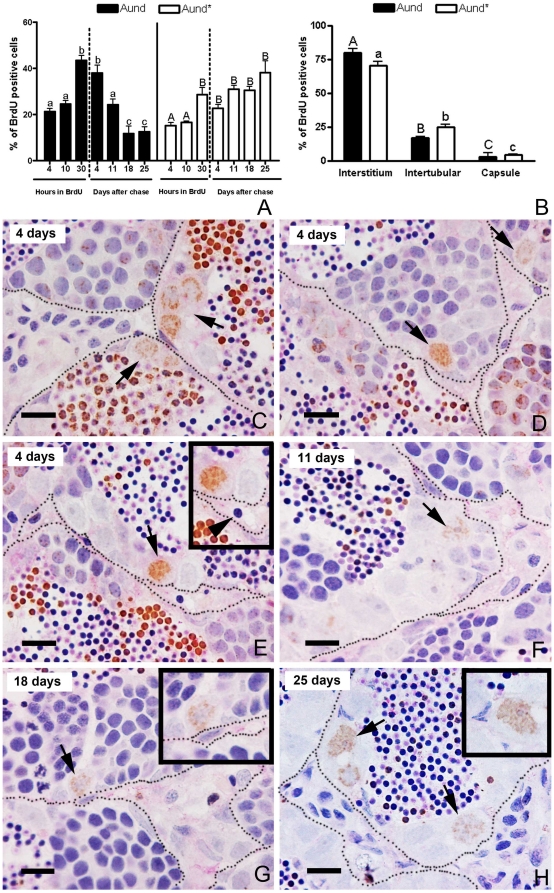
Label retaining cell (LRC) approach in zebrafish testes.
A. BrdU labeling index of type Aund* and Aund during BrdU exposure (4, 10, and 30 h) and after 4, 11, 18 and 25 days of chase. Bars represent the percentage mean ± SE (n = 5); different letters denote significant differences (p<0.05) in time. B. Distribution of BrdU-positive Aund* and Aund spermatogonia after 18 and 25 days of chase. Bars represent the mean ± SE which are expressed as percentage, and different letters indicate significant differences (p<0.05) among the groups. C–H. BrdU immunodetection with PAS staining after 4 (C–E), 11 (F), 18 (G), and 25 (H) days of chase. Note that BrdU immunostaining is diluted as a consequence of the progression of spermatogenesis. Only the slow-cycling cells (stem cells candidates) are able to retain the BrdU label for long periods of time. LRCs are indicated by arrows. Some of LRC are near to blood vessels (arrowhead) (E). Insets are high magnification of the LRCs (type A undifferentiated spermatogonia). The interstitium is delimited by spotted lines. Scale bars  = 10 µm.